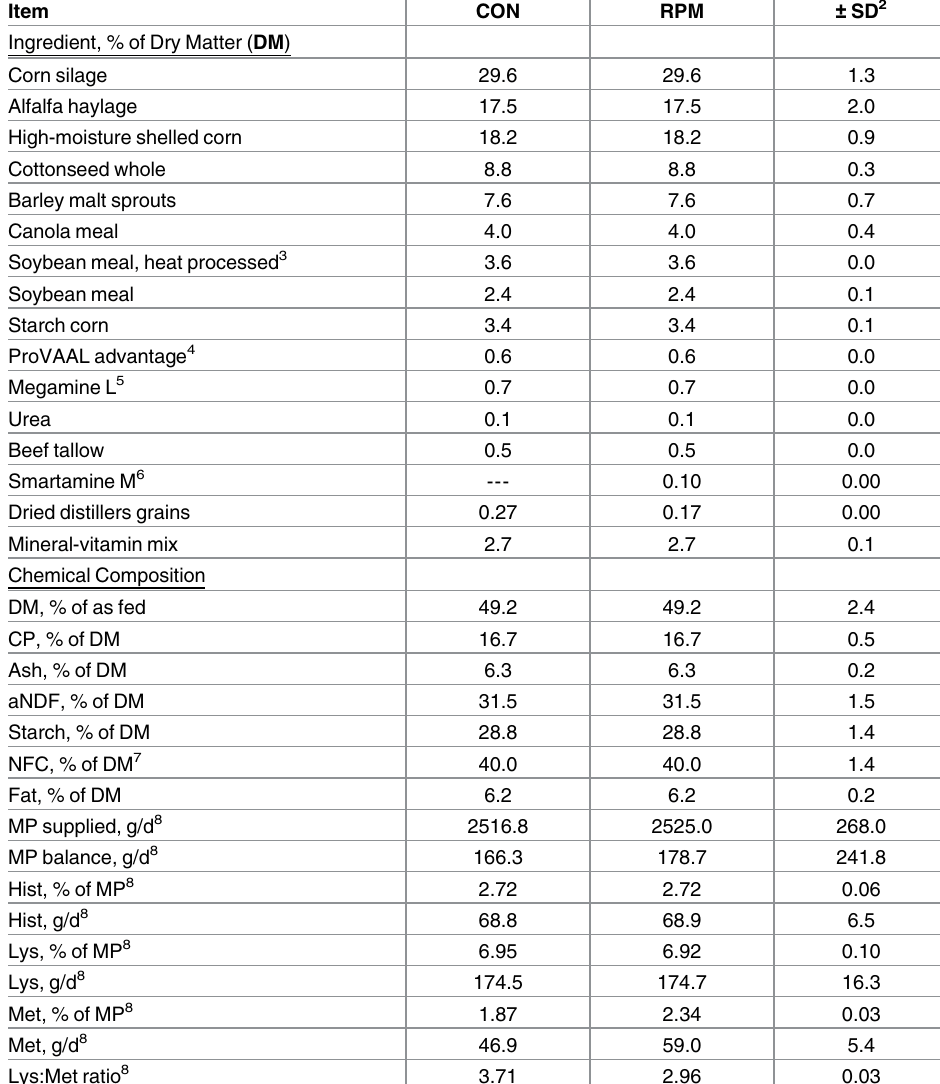
Table 1. Ingredient and chemical composition of the experimental